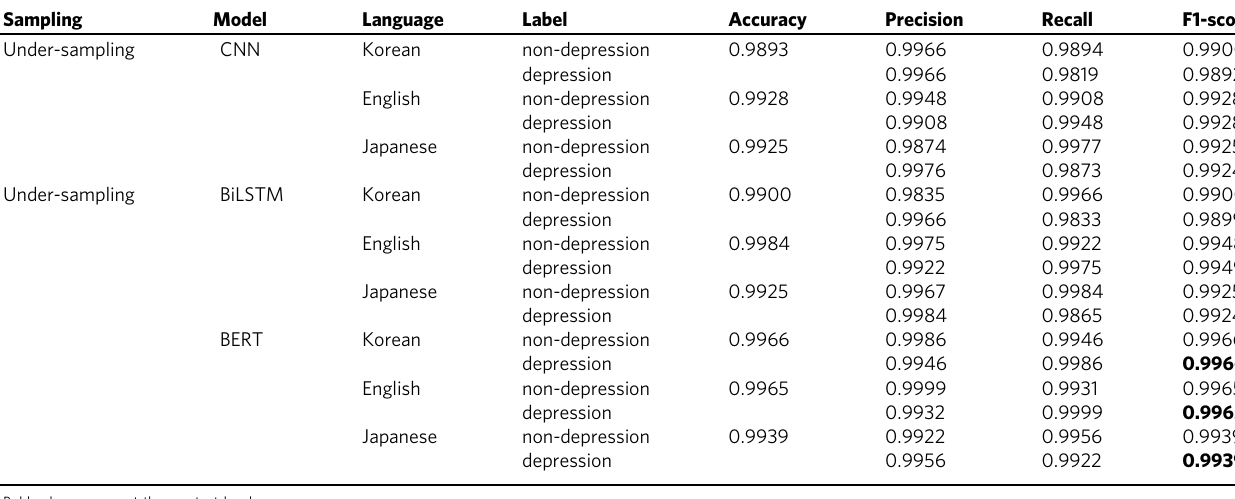
Bold values represent the greatest